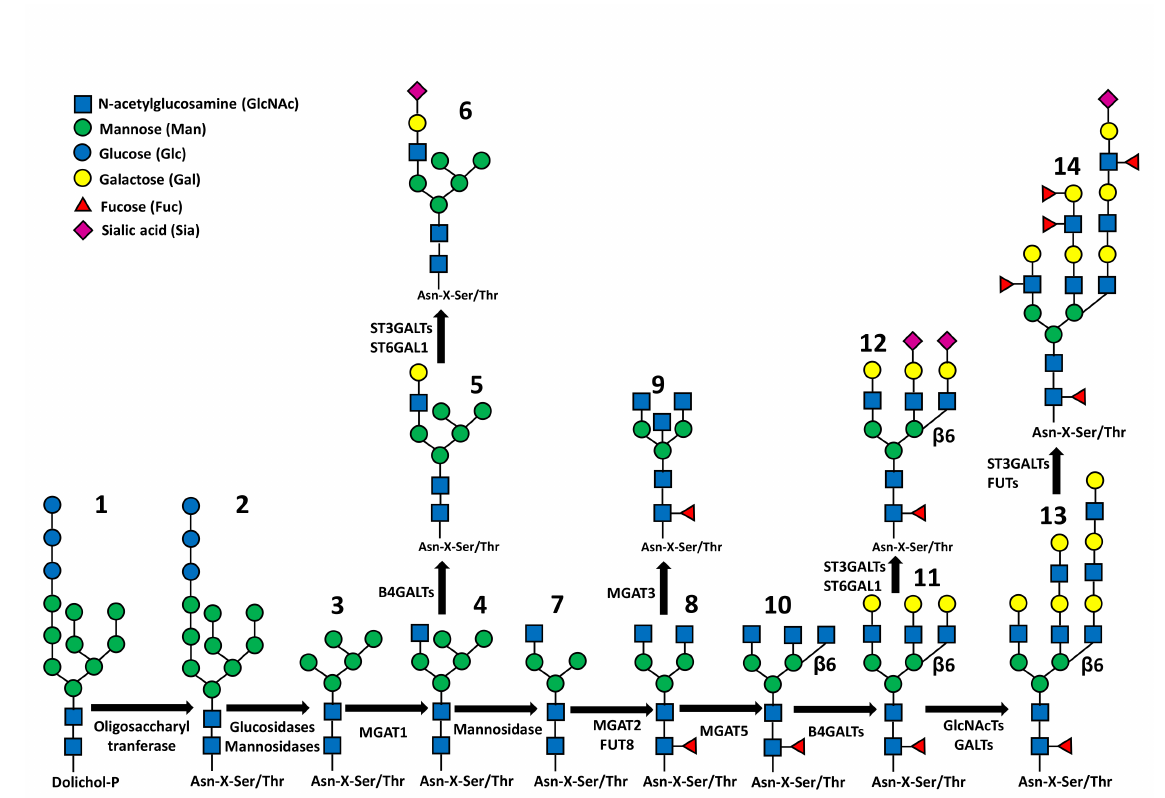
Figure 1. Synthetic representation of N -glycan biosynthesis. Structures 1 and 2: the Glc 3 Man 9 GlcNAc 2 structure attached to dolichol phosphate (1) or to polypeptide (2). Structure 3: Man 5 GlcNAc 2 structure product of the trimming of 4 Man and 3 Glc residues. Structure 4: addition of the first outer β 1,2-linked GlcNAc. Structures 5 and 6: hybrid type structures in which 5 Man residues coexist with a fully processed branch. Structure 7: trimming of the last 2 Man residues. Structure 8: addition of the second outer β 1,2-linked GlcNAc and of “core-linked” fucose. Structure 9: addition of the “bisecting” β 1,4-linked GlcNAc. Structure 10: addition of the β 1,6-linked GlcNAc. Structure 11: addition of β 1,4-linked Gals. Structure 12: addition of some Sia residues either α 2,3 or α 2,6-linked. Structure 13: Elongation of the branches by sequential action of GlcNAcTs and GalTs. Structure 14: addition of sialic acids and external fucose residues. The fucosylated structure present on the left branch could be either the Le a or the Le x structure, depending on the Fuc linkage to GlcNAc ( α 1,4 for Le a ; α 1,3 for Le x ). The fucosylated structure present on the internal branch could be either the Le b or the Le y structure, depending on the Fuc linkage to GlcNAc as above. The β 1,6-linked branch on the right is terminated by a sialylated Lewis a or Lewis x